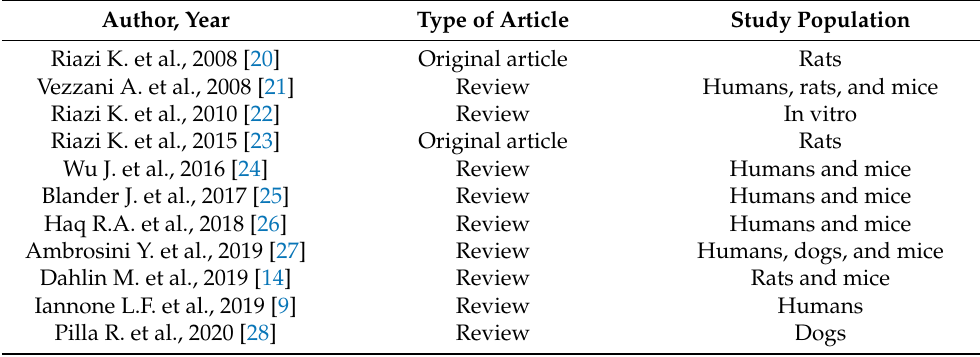
Table 1. List of articles eligible for the role of GM and GBA in epileptogenesis according to